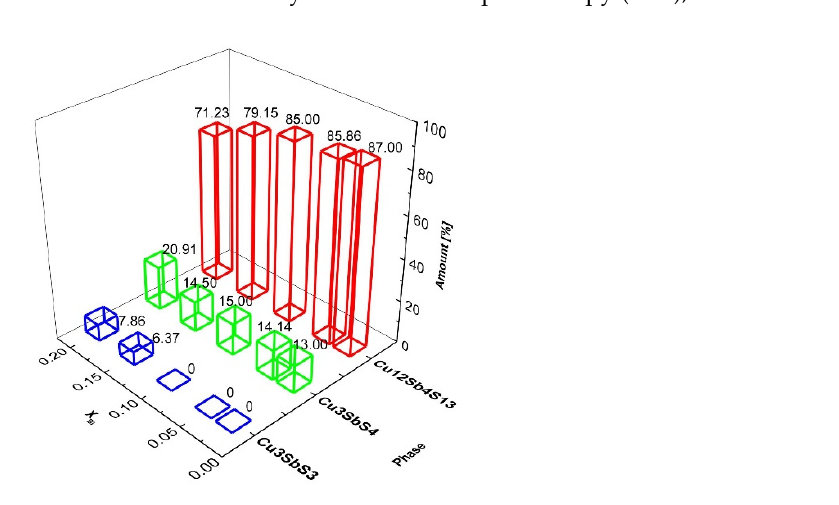
Figure 2. Phase distribution of tetrahedrite Cu 12 Sb 4 S 13 , famatinite Cu 3 SbS 4 and skinnerite Cu 3 SbS 3 for sintered samples as a function of the nominal Bi content, X Bi .